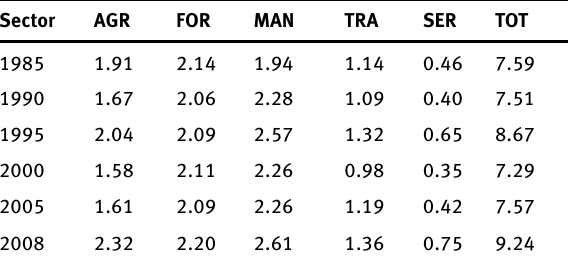
Table 1: Summary of Total Multiplier (Ma) from forest-related sectors Sector AGR FOR MAN TRA SER